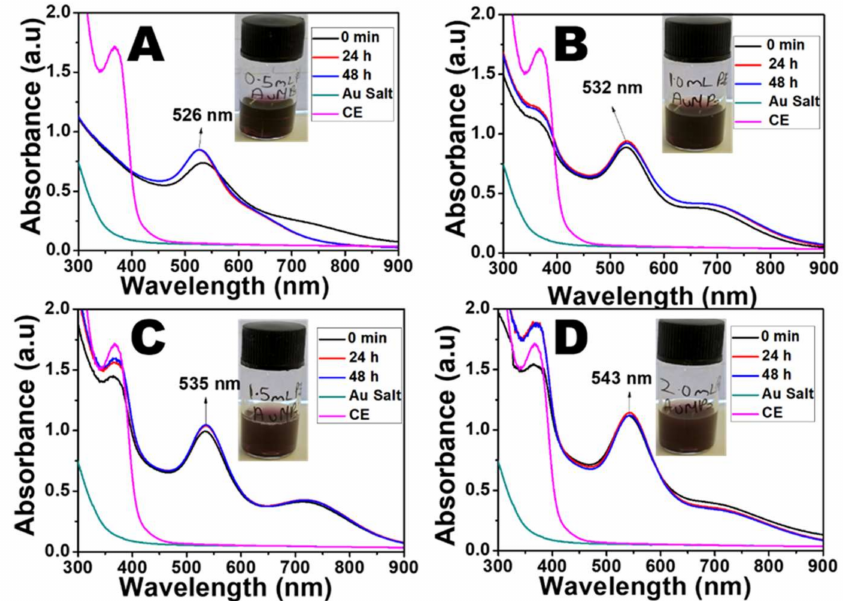
Figure 1. Absorption spectra of CE-AuNPs using ( A ) 0.5 mL CE, ( B ) 1.0 mL CE, ( C ) 1.5 mL CE, and ( D ) 2.0 mL